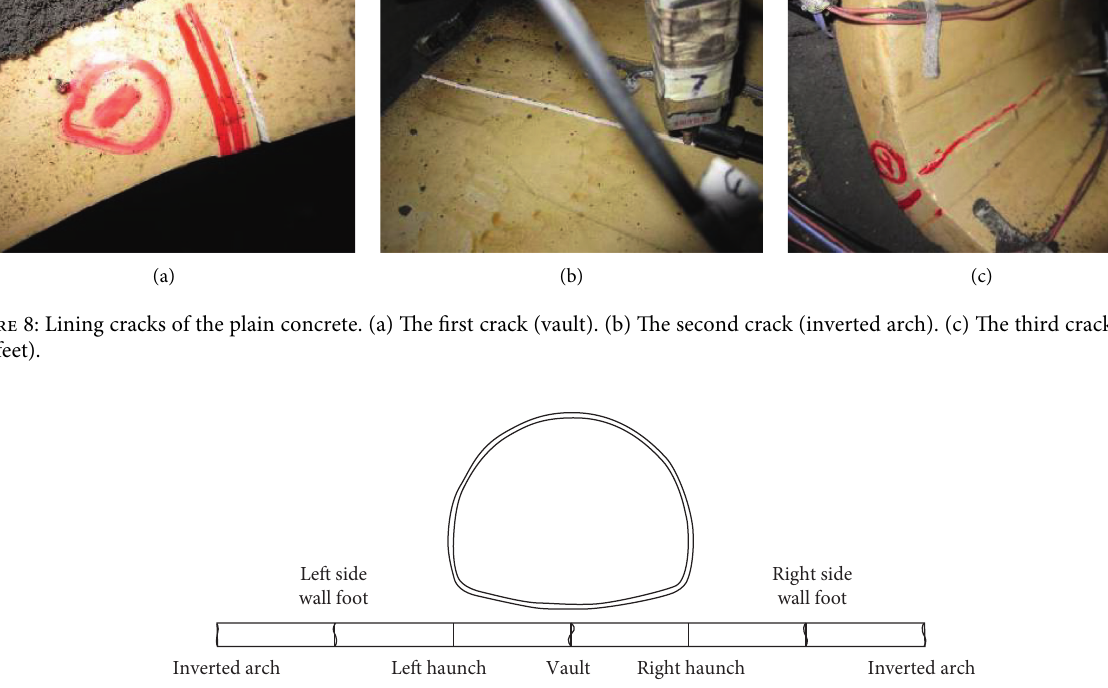
Figure 9: Distribution of lining cracks of the plain concrete.